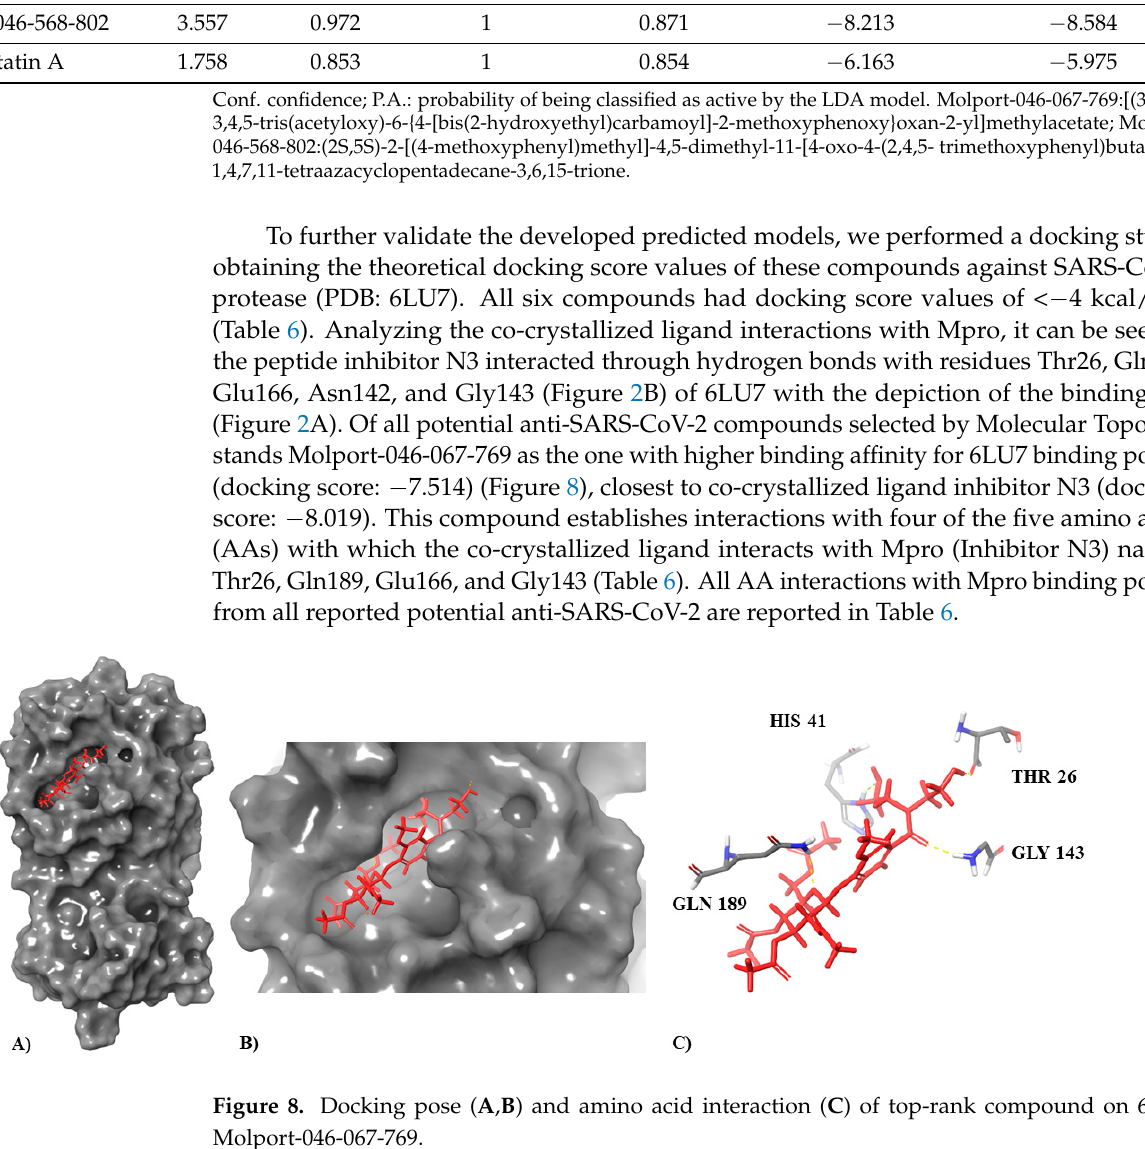
Figure 8. Docking pose ( A , B ) and amino acid interaction ( C ) of top-rank compound on 6LU7: Mol-port-046-067-769.